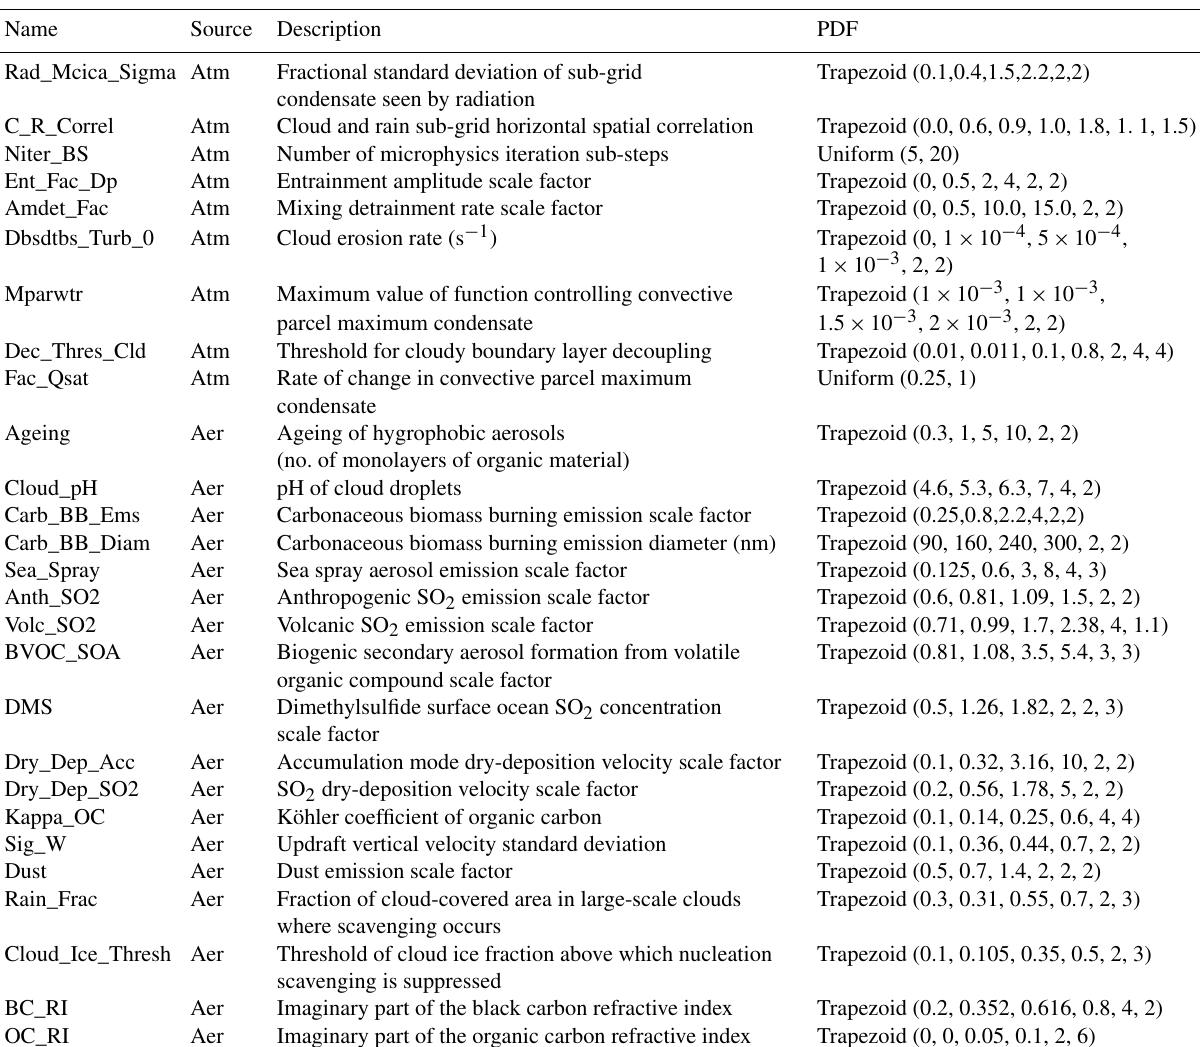
Table 1. Descriptions of the perturbed parameters. Parameters are grouped according to their source within the model as either “Atm” for atmospheric or “Aer” for aerosol